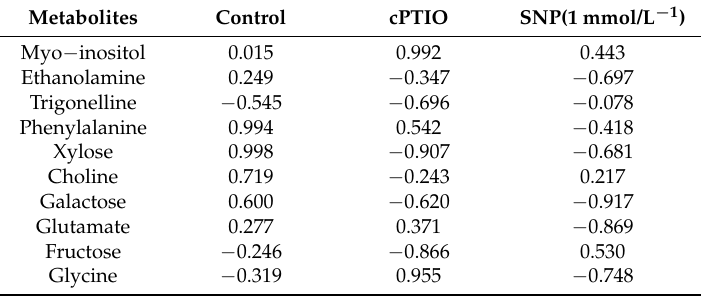
Table A2. The correlation between the content of 12 metabolites which had VIP value greater than 1 and betulin